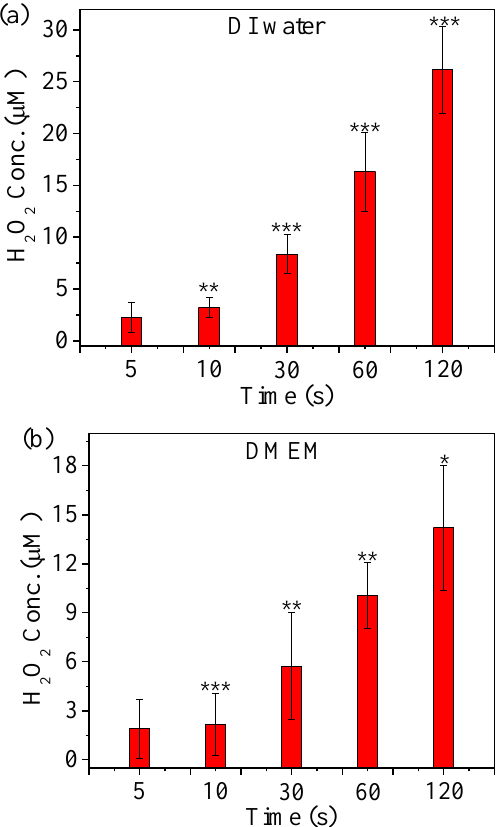
Figure 5. H 2 O 2 concentration in µCAP-treated DI water ( a ) and DMEM ( b ). Student t -test was performed, and the statistical significance compared to µCAP 5 second treatment is indicated as * p < 0.05, ** p < 0.01, *** p < 0.001. ( n = 3).